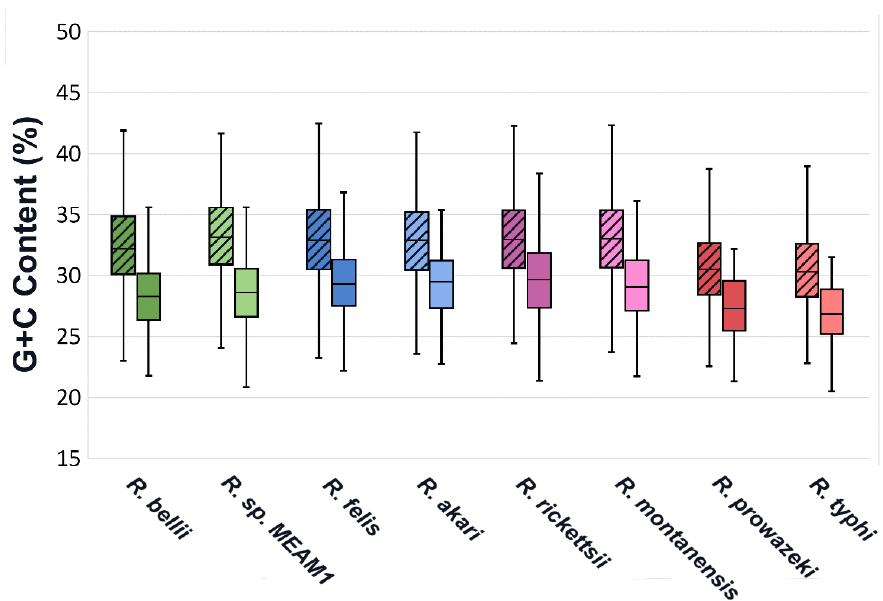
Figure 3. G+C content range of EHSs for each species compared to all other coding sequences. Non-effector genes are represented by plots with diagonal hatching, while Effectors are in open plots. Effector sets are significantly different than Non-effectors in all species, with p values below 0.001 in all instances.